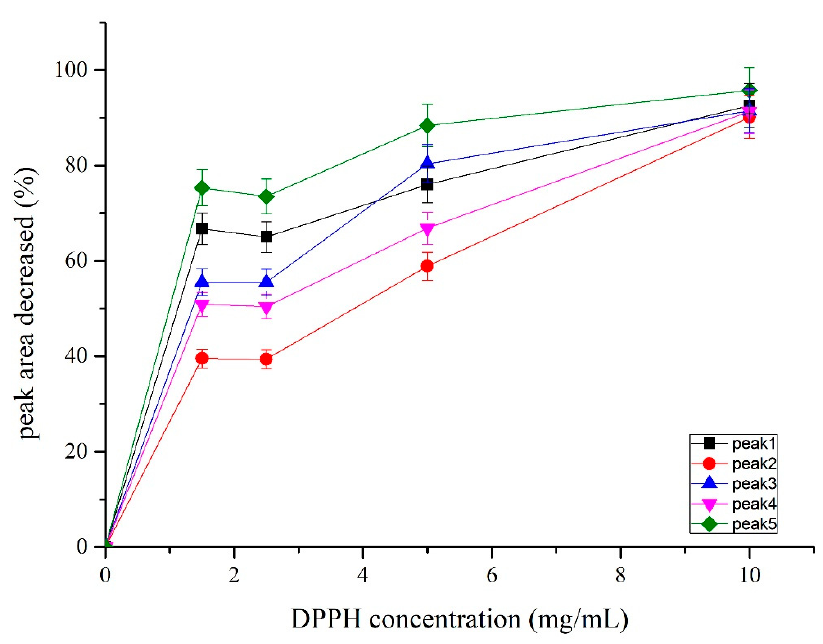
Figure 3. The peak areas of peaks 1–5 reduced after treated with di ff erent concentrations of DPPH Figure 3. The p eak areas of peaks 1–5 reduced after treated with different concentrations of DPPH methanol solution (stock methanol solution (stock concentration).